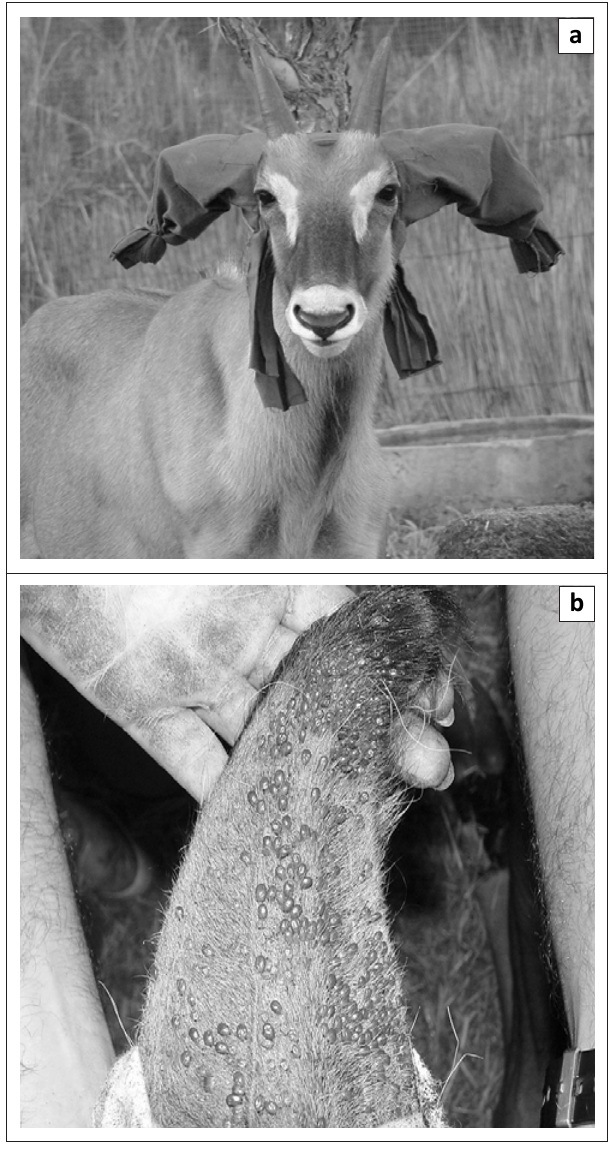
FIGURE 6: (a) Calico cloth ear-bags protecting Rhipicephalus appendiculatus nymphae feeding on a roan antelope calf and (b) Engorged Rhipicephalus appendiculatus nymphae ready to be